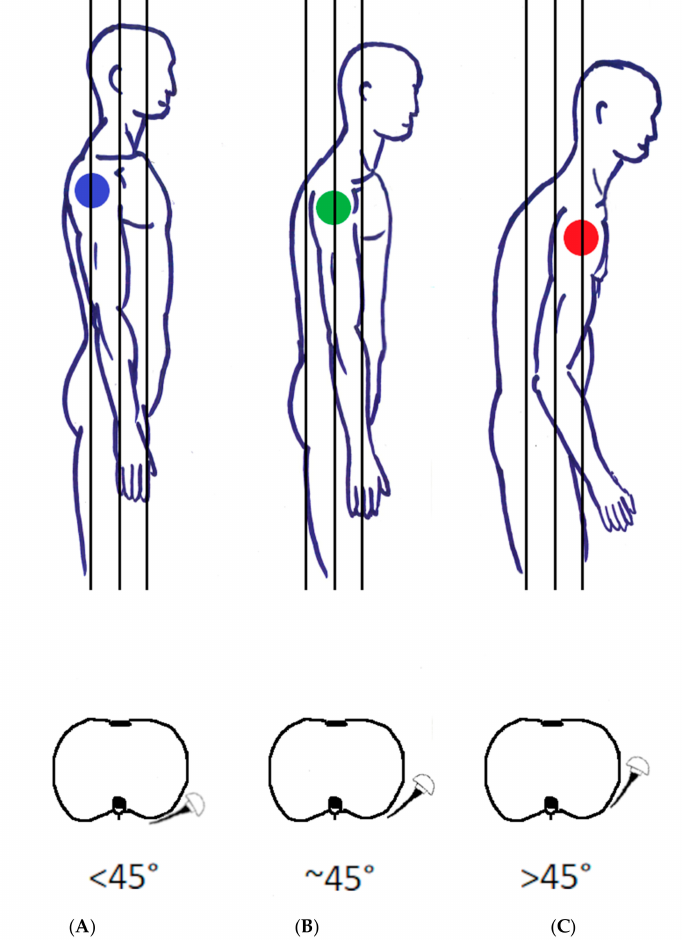
Figure 6. Scapular orientation according to thoracic kyphosis. ( A ) Normal position. ( B ) Mild kyphosis altering scapular orientation. ( C ) Severe kyphosis with pronounced scapular internal